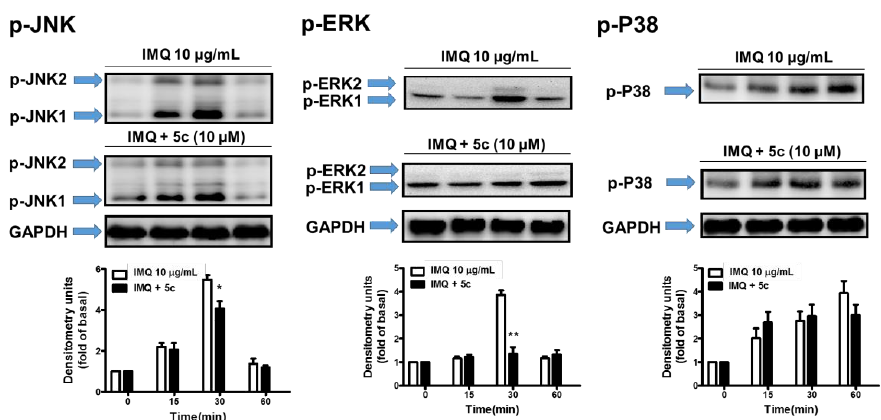
Figure 5. Effect of 5c on inhibition of p-JNK1/2, p-ERK1/2 and p-38 in differentiated HaCaT cells was done by Western Blot. The cells were incubated with IMQ alone, IMQ with different concentrations of 5c in media containing 2% FBS for 24 h at 37 °C. Data are presented as mean ± SD ( n = 3).